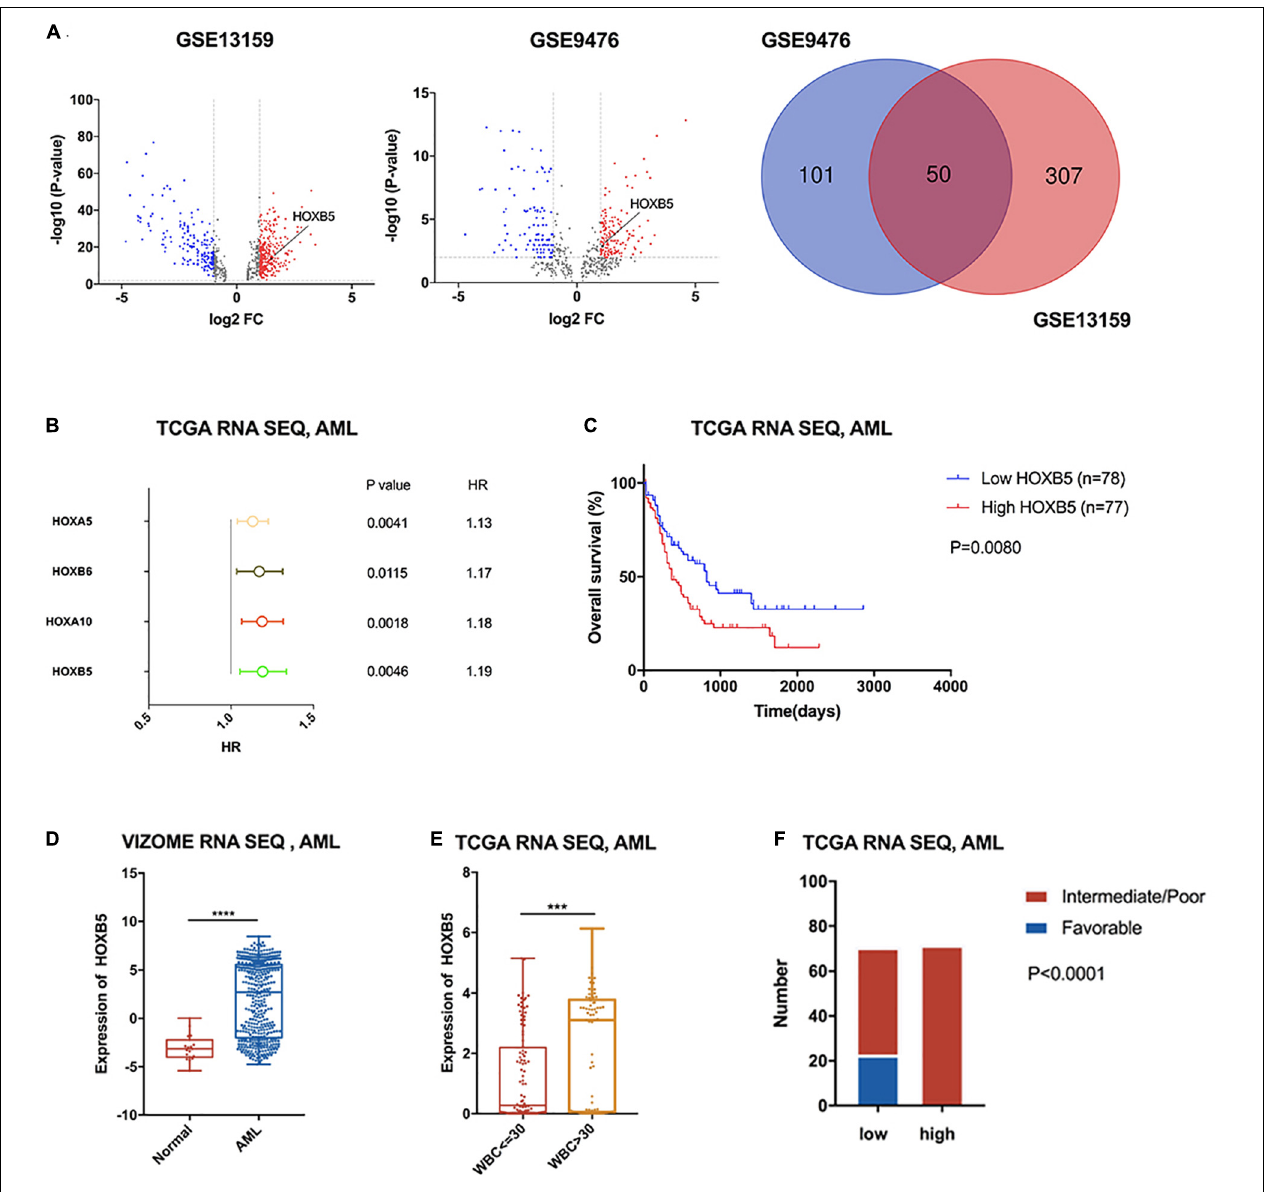
FIGURE 1 | HOXB5 was up-regulated in AML with significant prognostic value and correlated with clinical characters of AML. (A) Volcano plots and a Venn plot showing DEGs between AML patients and healthy volunteers (GSE13159 RNA-seq, AML n1 = 542, normal n2 = 74; GSE9476 RNA-seq, AML n1 = 26, normal n2 = 10). (B) A forest plot showing Cox regression analyses of HOX genes included in the 50 overlapping genes using TCGA RNA-seq database. (C) Survival analysis revealed HOXB5 expressed prognostic value in AML (with log-rank test). (D) HOXB5 expression difference between AML patients and healthy volunteers (VIZOME, normal n = 19, AML n = 440; with t test). (E) The expression difference of HOXB5 between the groups above or below the set point (30 × 10 9 /L) of WBC count (with t test). (F) χ 2 test showing the relationship between HOXB5 expression and cytogenetic risk in AML of TCGA RNA sequencing database. *** P < 0.001, **** P <